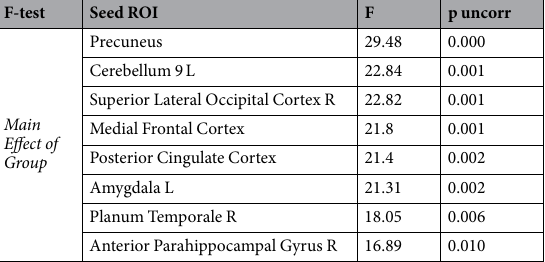
Table 1. Lean controls vs presurgery patients: effect of group on